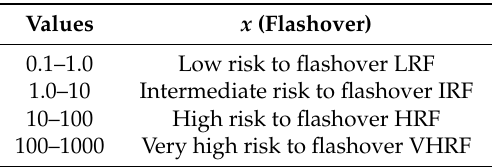
Table 1. Two parameters for predicting fire hazard.